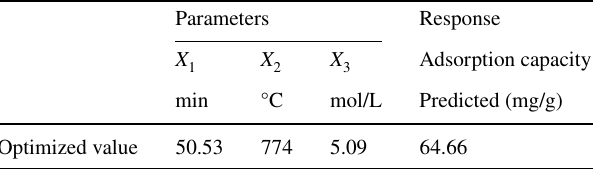
Table 4 The optimum conditions for preparation banana trunk-acti- vated carbon and the percentage adsorption capacity of the predicted result for prepared activated carbon